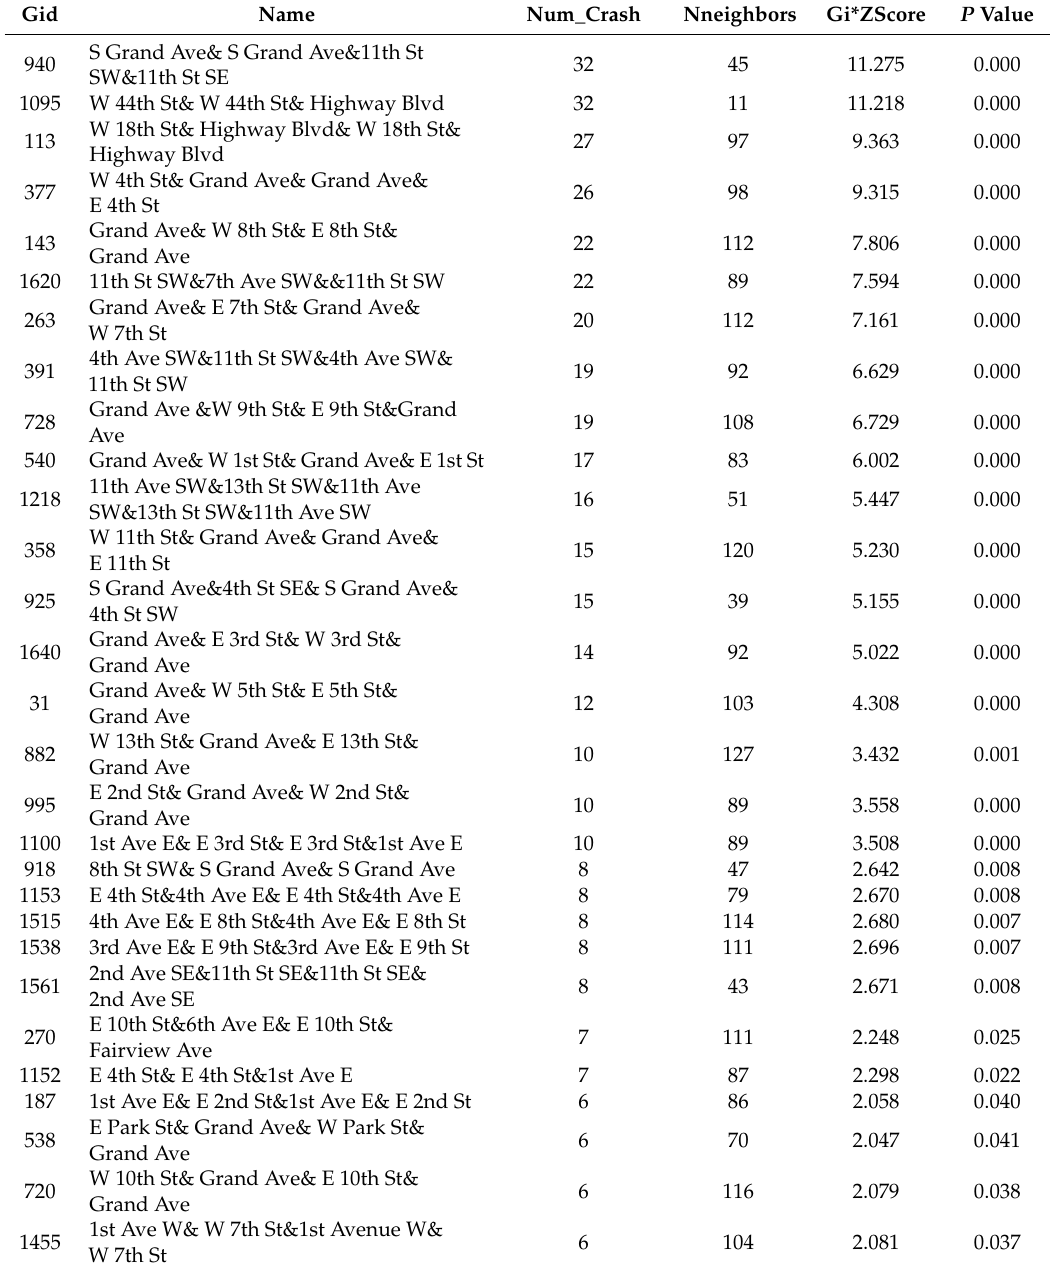
Table 5. Gi*ZScores and p -values of intersections in